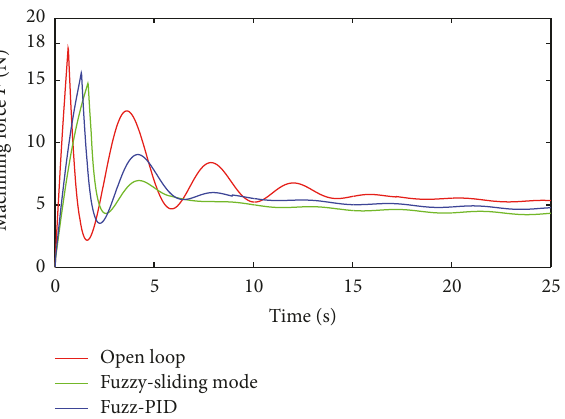
Figure 6: Control performance comparisons (fuzzy-PID, fuzzy- sliding mode, and open loop).